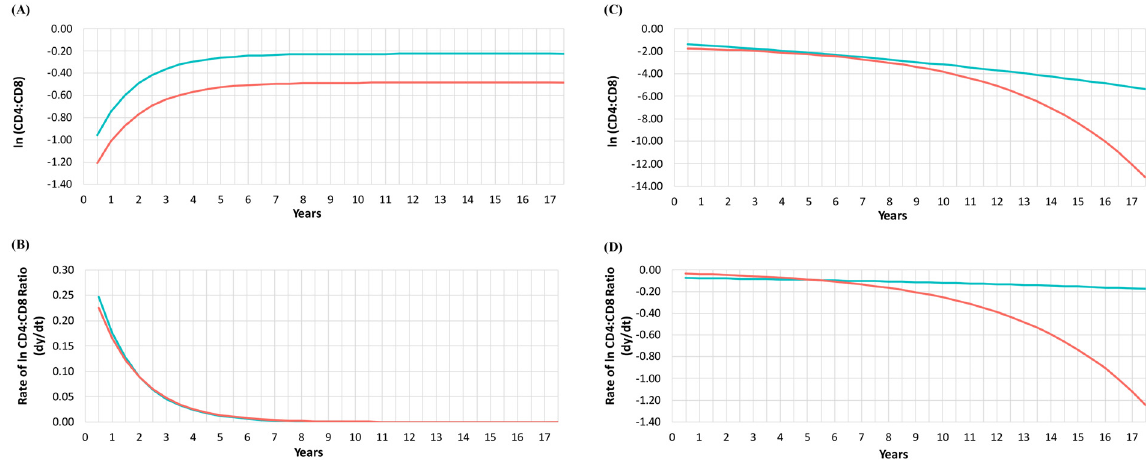
Figure 1. ln ( CD 4 : CD 8 ) trajectory and loss rate plots per six months by chronic kidney disease (CKD) status. ( A ) Estimated trajectory in Class 1. ( B ) Estimated trajectory in Class 2. ( C ) Estimated loss rate for Class 1. ( D ) Estimated loss rate for Class 2. Red line CKD and Green line no CKD.